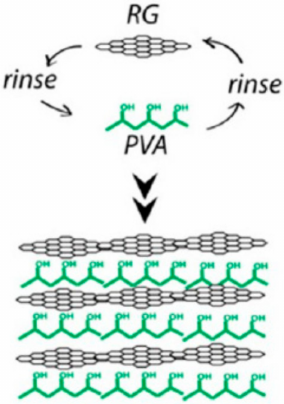
Figure 8. Layer-by-layer assemble for manufacture of GRPCs. Reproduced with permission from [111]. Copyright 2013, American Chemical Society.